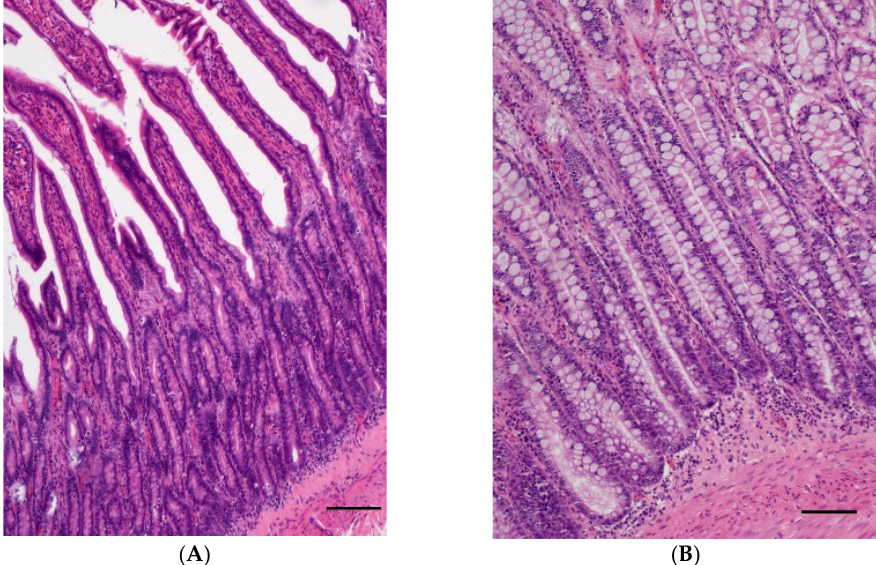
Figure 1. ( A ) Normal intestinal mucosa of the jejunum of a 10-year-old male castrated West Highland White Terrier; (HE, bar = 200 µ m). ( B ) Normal intestinal mucosa of the rectum of a 7-year-old female neutered Airedale Terrier; (HE, bar = 200 µ